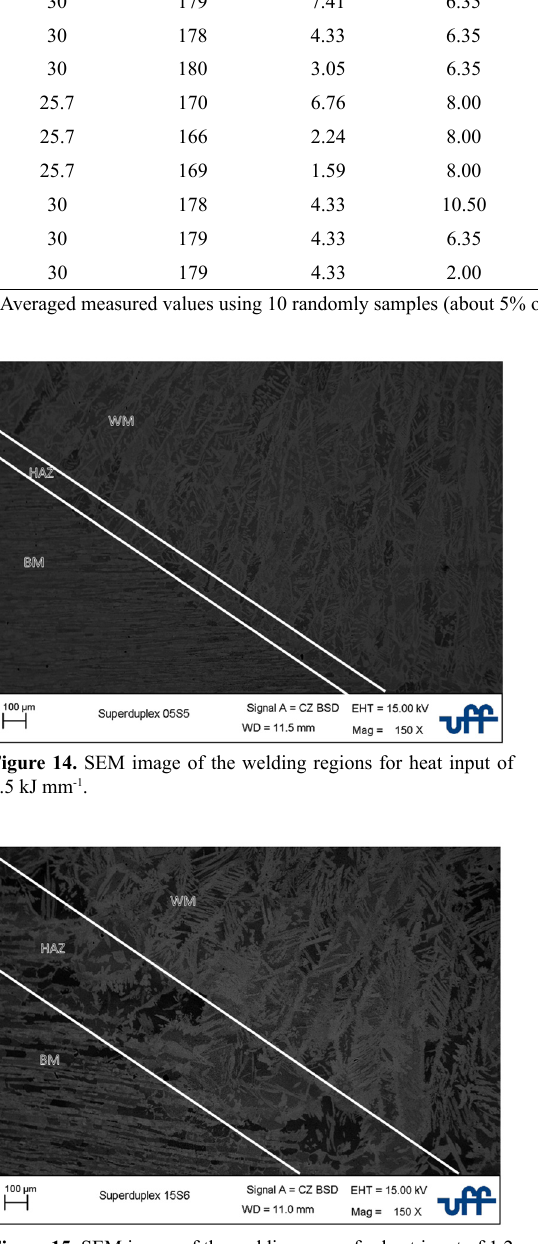
Figure 15. SEM image of the welding zones for heat input of 1.2 kJ mm -1 .